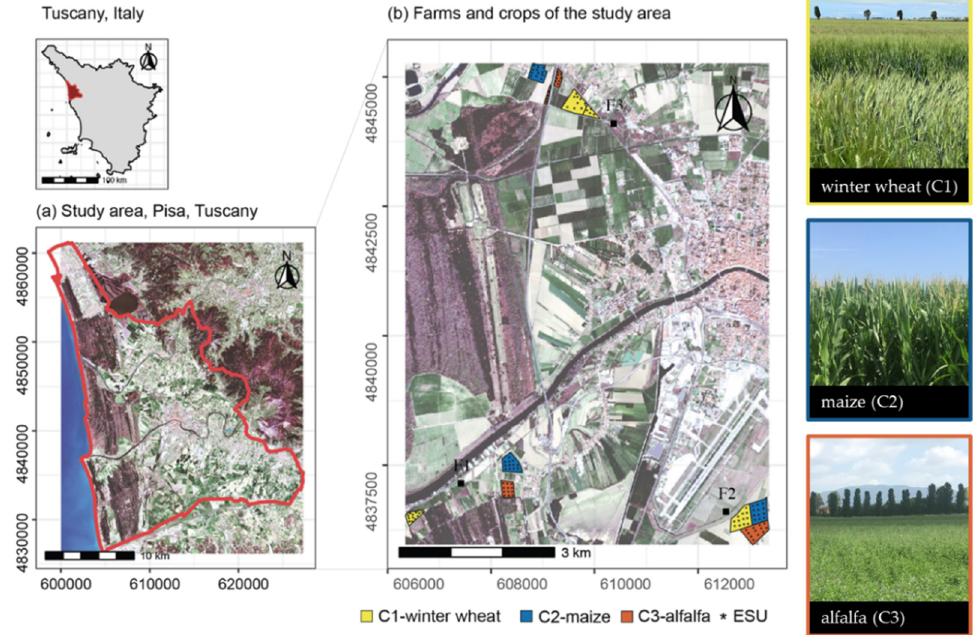
Figure 2. ( a ) Study area in Tuscany, Italy; ( b ) farms and crops of the study area (C1—winter wheat, C2—maize, and C3—alfalfa) in the three farms (F1—San Piero, F2—Coltano, and F3—Madonna dell’Acqua) in Pisa, Italy.